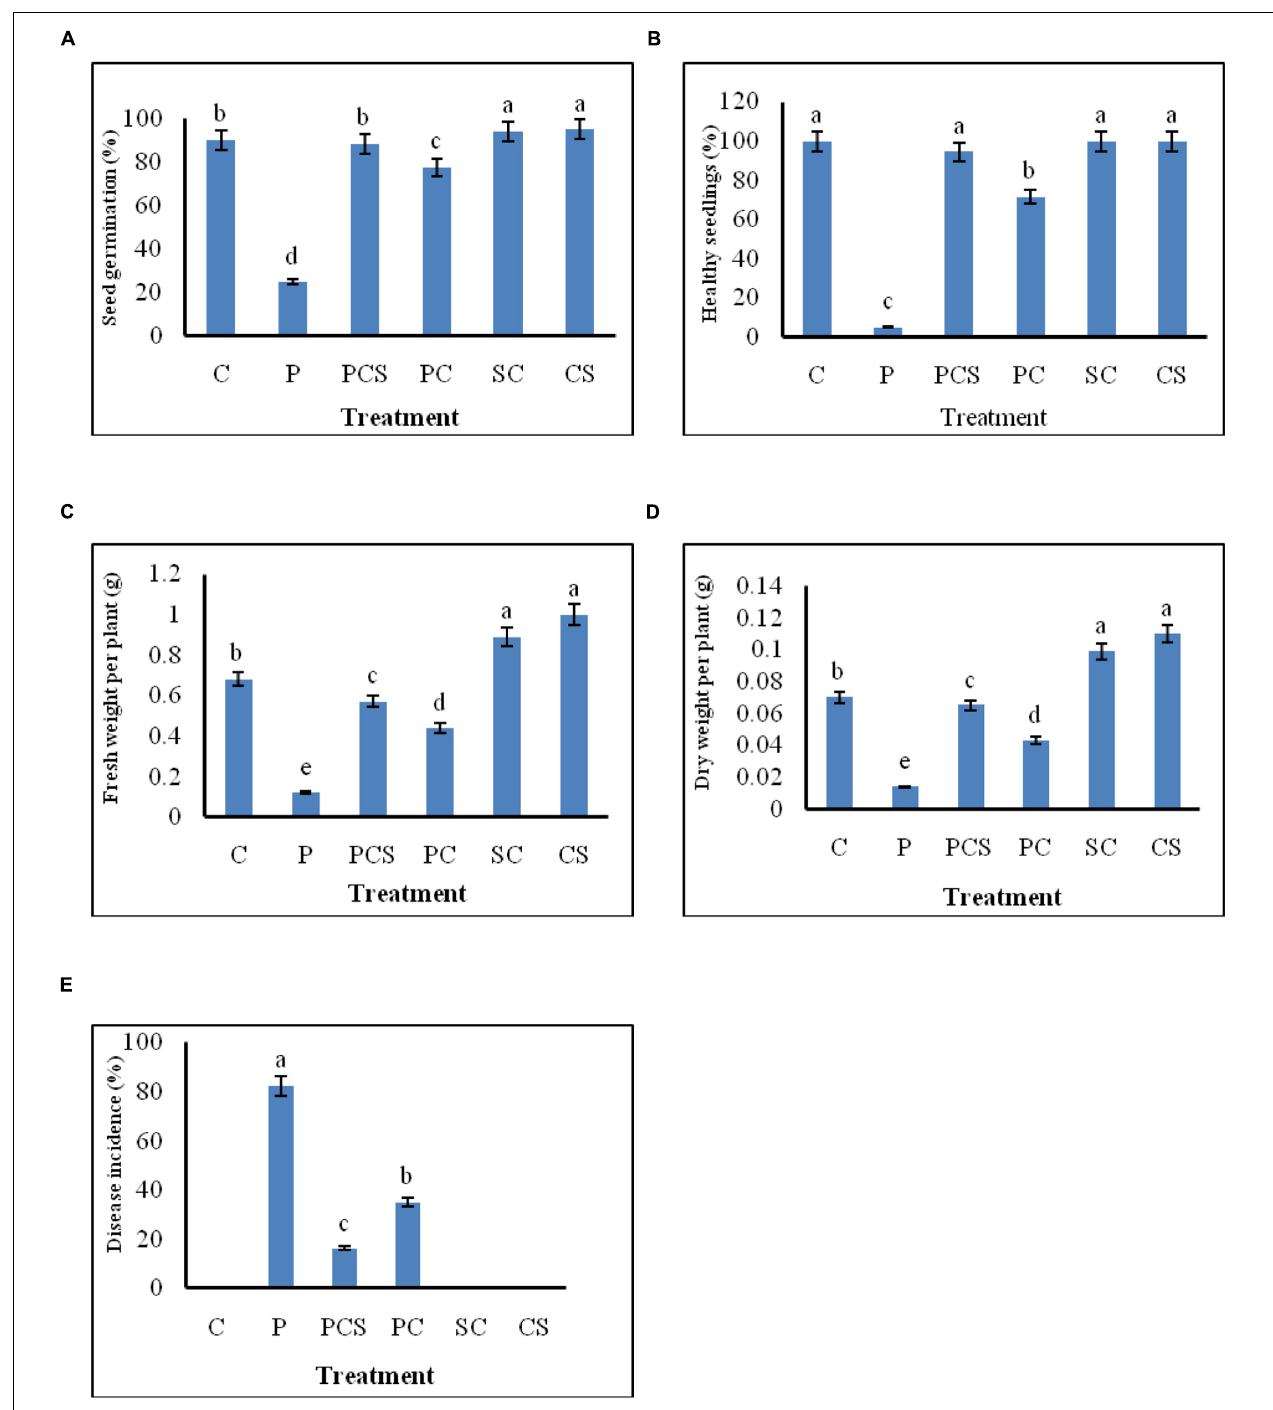
FIGURE 4 | Effect of S. hydrogenans cells and its culture extract as seed dressing on R. sativus to control A. brassicicola damping off of seedlings. (A) percentage germination (B) emergence of healthy seedlings (C) fresh weight per plant (D) dry weight per plant (E) disease incidence; Data represents means of two experiments with five different treatments of artificially A. brassicicola inoculated seeds, each treatment consist of three plates per experiment with 10 seeds per plate, i.e., total 60 seeds for each different treatment. Error bars represent approximate 95% confidence limit. Same letters on the bar are not significantly different according to Tukeys test ( p ≤ 0.01); C, Control (Water only); P, Pathogen only; PE, Pathogen + Extract; PC, Pathogen + Streptomyces cells; SC, Streptomyces cells only.